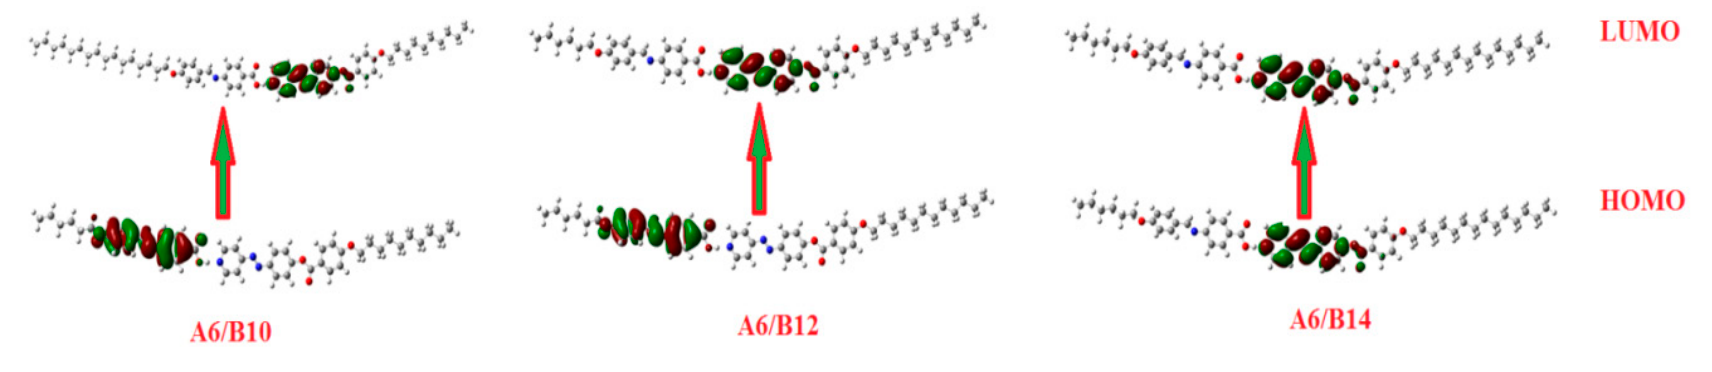
Figure 8. The estimated plots for frontier molecular orbitals of A6 / Bm SMHBC conformers.